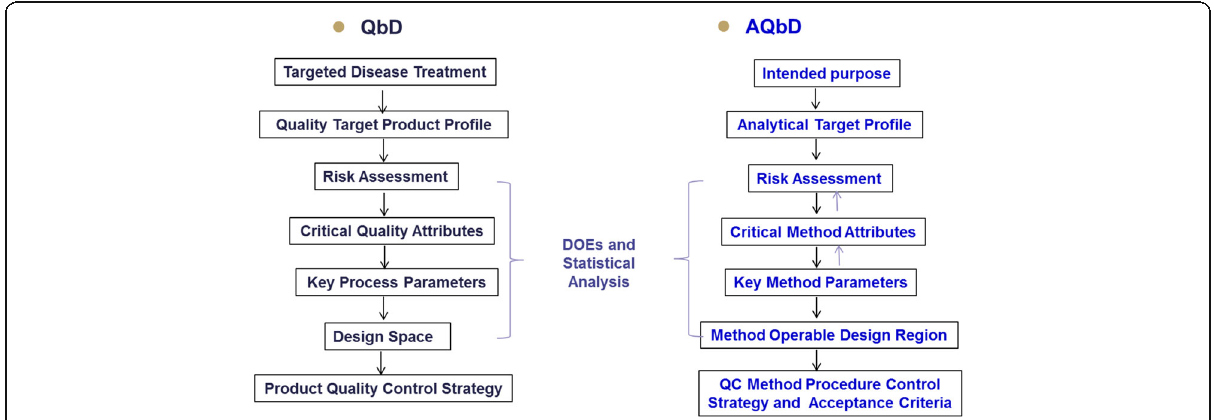
Fig. 3 Parallel comparison of QbD for product development vs AQbD for method development. (permitted to